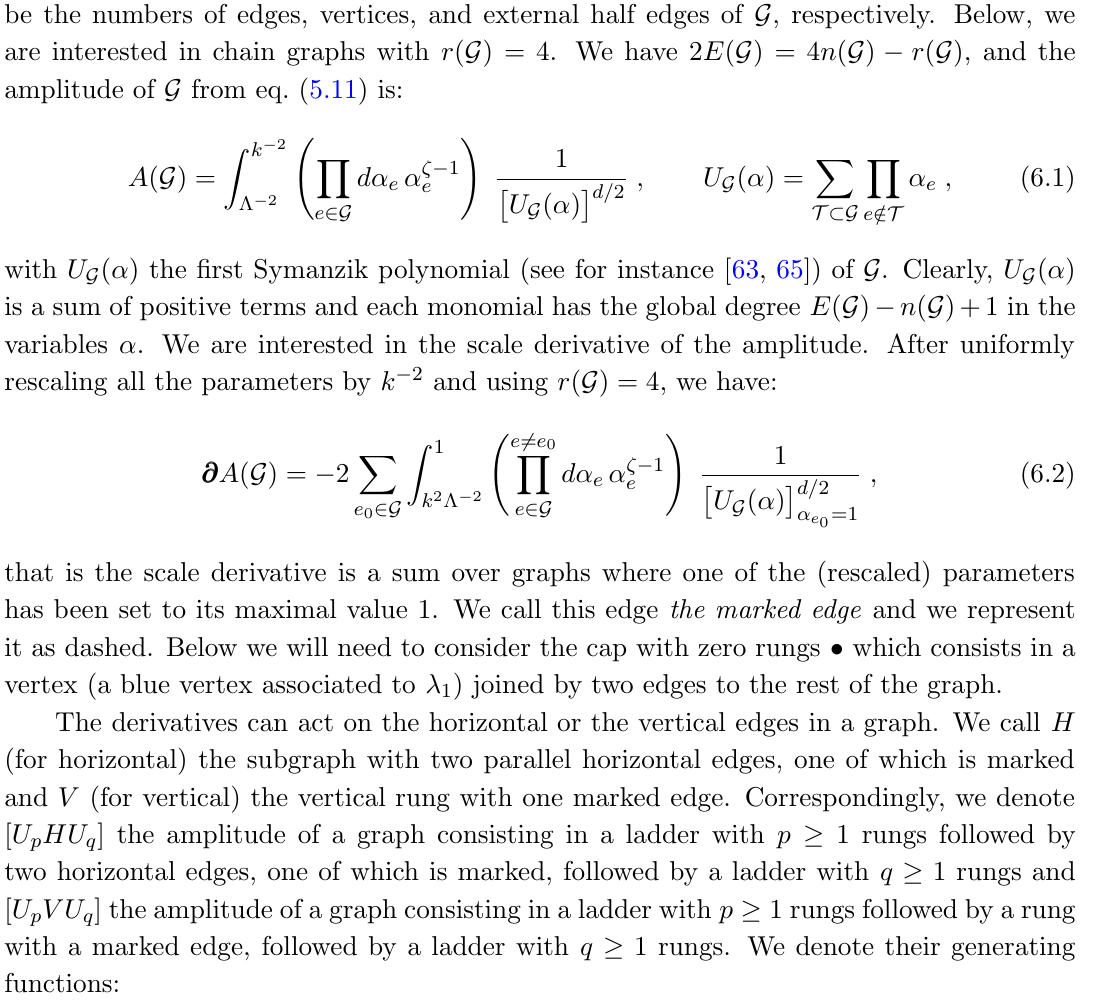
Figure 11 . From left to right, the graphs [ U 1 HU 1 ] and V; [ V U 1 ] ; [ U 1 V ] and [ U 1 V U 1 ]. The scale